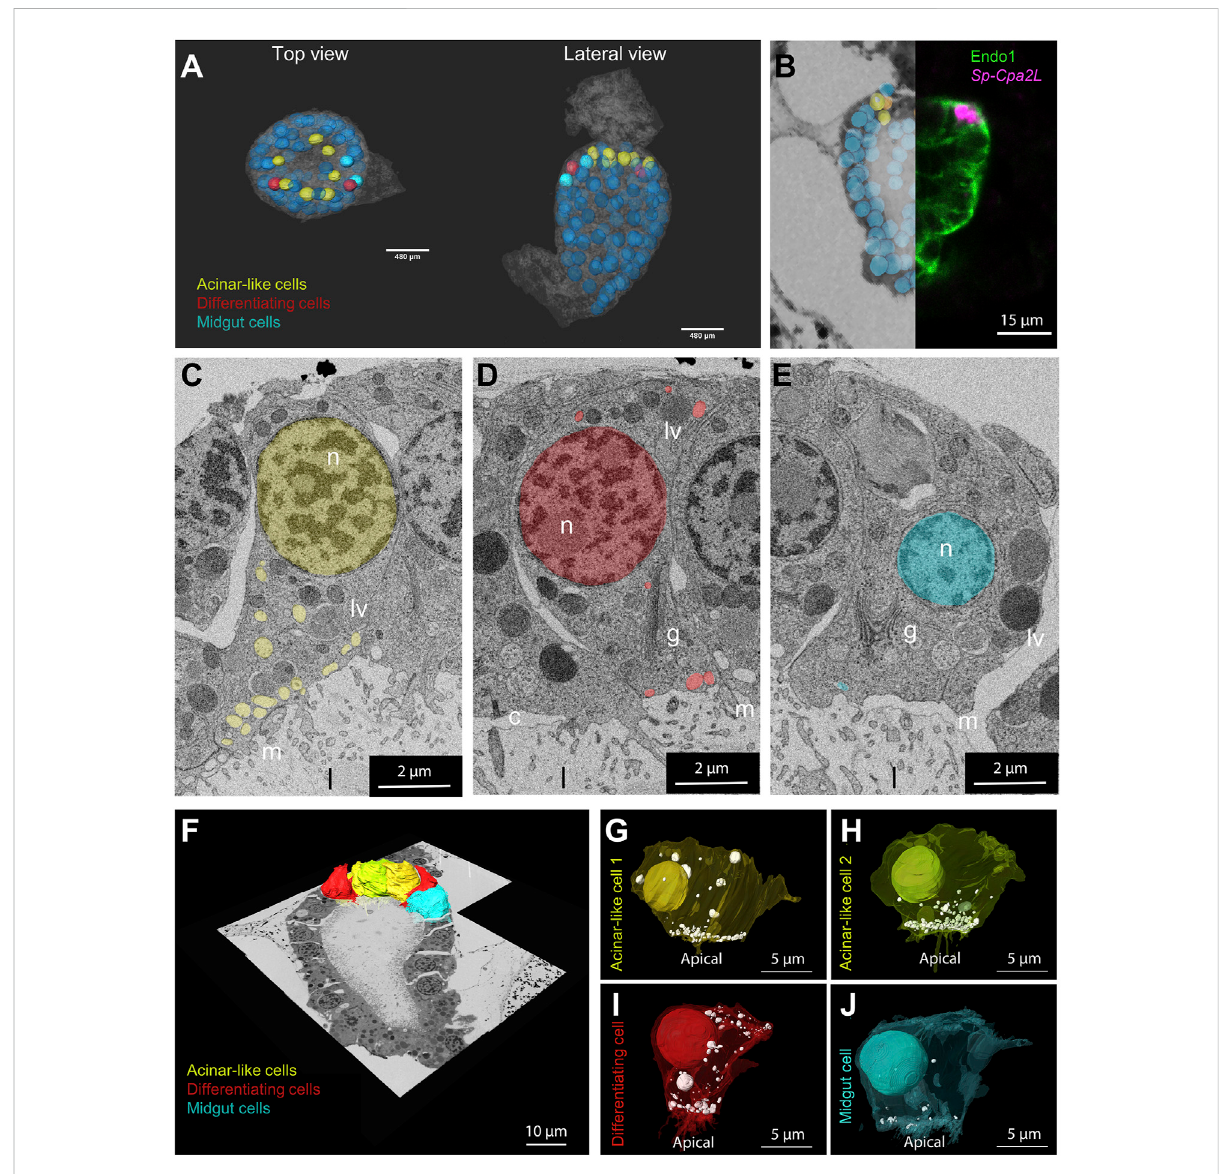
FIGURE 4 Morphological characterization of the S. purpuratus larva exocrine pancreas-like cells. (A) Nuclei segmentation of the entire midgut region in which cell membranes are visible (semitransparent). Midgut (blue), differentiating (red) and exocrine pancreas-like nuclei (yellow) are shown. The nuclei shown with lower transparency are the ones segmented and used for the analysis. Cell membranes are semi-transparent. (B) Overlay and stitching of the FISH for Sp-Cpa2L (magenta), IMH for endo1 and the vEM dataset. (C – E) Isolated slices showing an example of the vesicle relative number and polarization per cell type identi fi ed. 3D reconstruction of the cells located in the upper part of the midgut region. Plasma membranes of cell types analyzed were segmented and shown projected on the stitched EM dataset. (F – J) Individual 3D reconstructions of the segmentedcelltypesofinterest.Theplasmamembranesvisibleinasemi-transparentmanner,revealingthenucleiandvesiclenumberandposition. Yellow and lime, exocrine cell; Red, differentiating cell; cyan; main stomach cell. c, cilium; g, golgi; n, nucleus; l, lumen; lv, larger vesicles; m,